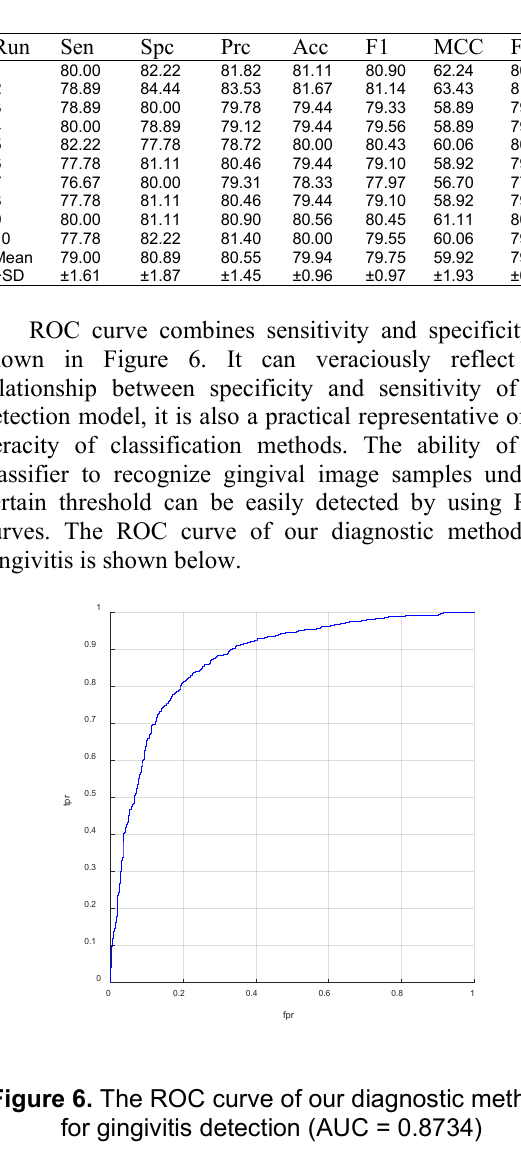
Table 2. Ten-fold cross validation results of the proposed method